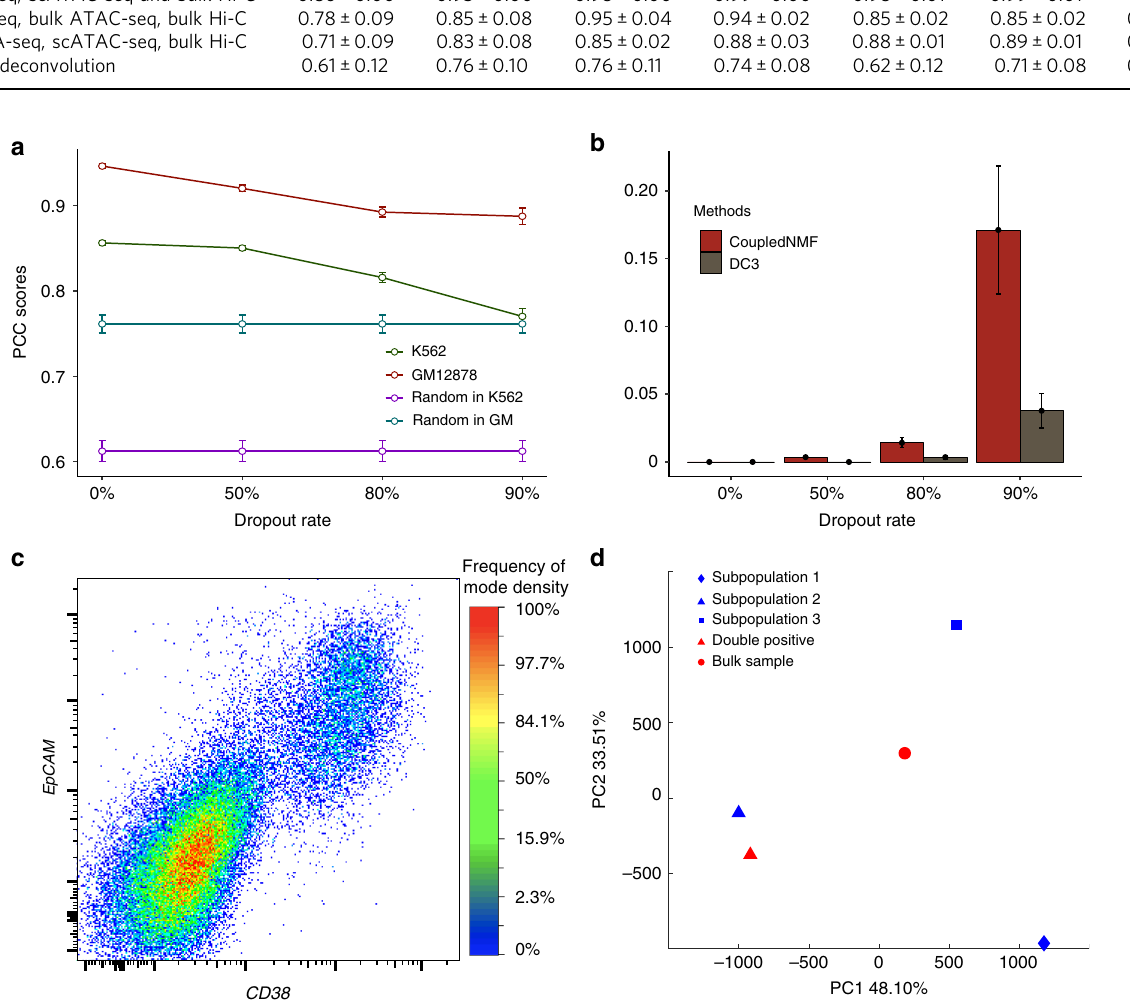
Fig. 2 Validation of DC3 in simulation and real data. a Performance of HiChIP deconvolution scRNA-seq and scATAC-seq for GM12878 and K562 simulation data under different drop out rates. As a comparison, the random deconvolution results are presented. Error bars represent standard deviation. b Performance of joint clustering for GM12878 and K562 simulation data under different drop out rates. Error bars represent standard deviation. c FACS plot shows that in RA-day 4, 15.7 ± 3.2% cells are double positive for population-2-markers EpCAM and CD38 . d Performance of HiChIP deconvolution in RA-day 4 real data. The HiChIP pro fi le measured from double positive cells (red triangle) is much closer to that inferred for subpopulation 2 (blue triangle) than to the HiChIP pro fi les inferred for the other subpopulation (blue circle and blue rhombus) or measured from the bulk sample (red circle). All HiChIP pro fi les are represented using n -dimensional vectors with each dimension indicates corresponding loop counts. Source data are